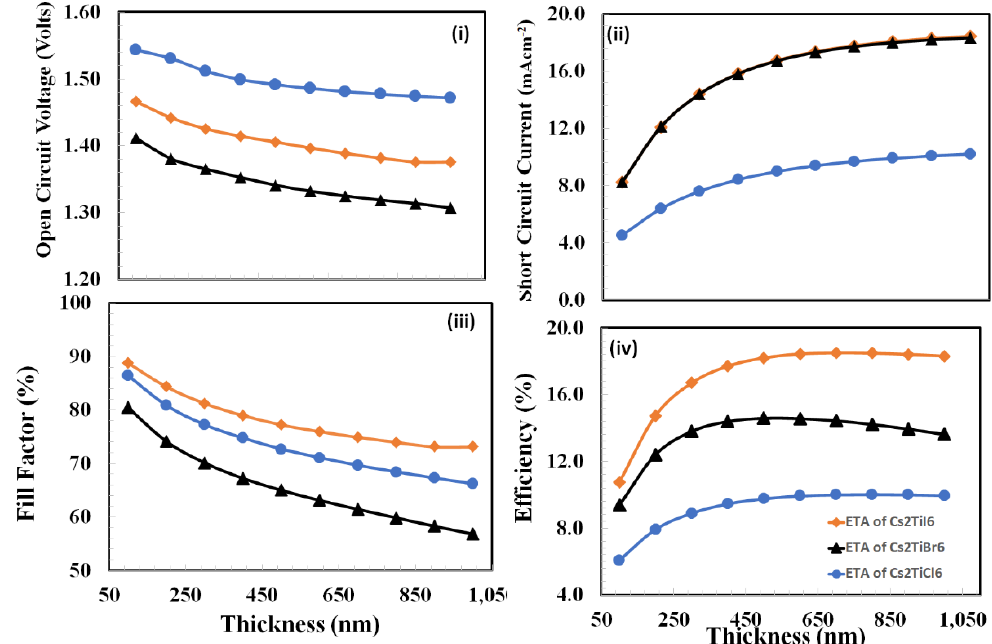
Figure 7. The photovoltaic response parameters: ( i ) open-circuit voltage, ( ii ) short-circuit current, ( iii ) fill-factor, and ( iv ) power-conversion efficiency as a function of the thickness of the active perovskite layer for the proposed devices Cs 2 TiCl 6 , Cs 2 TiBr 6 , and Cs 2 TiI 6 respectively. Table 3. The overall optimization parameters (thickness and doping density) of hole-transport, electron-transport, and active perovskite layer for proposed photovoltaic